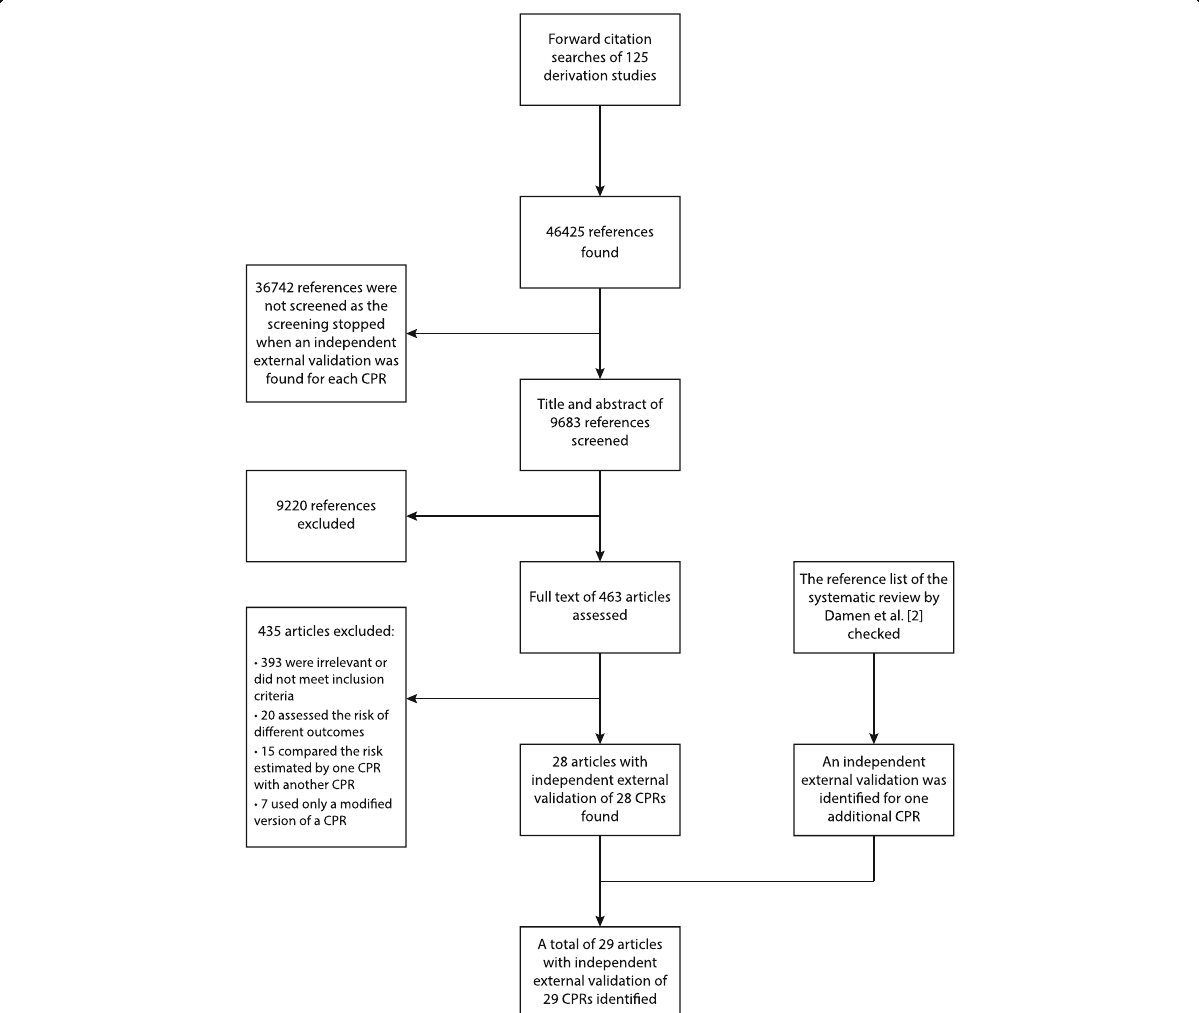
Fig. 1 Flow diagram. Identifying cardiovascular risk clinical prediction rules (CPRs) with an independent external